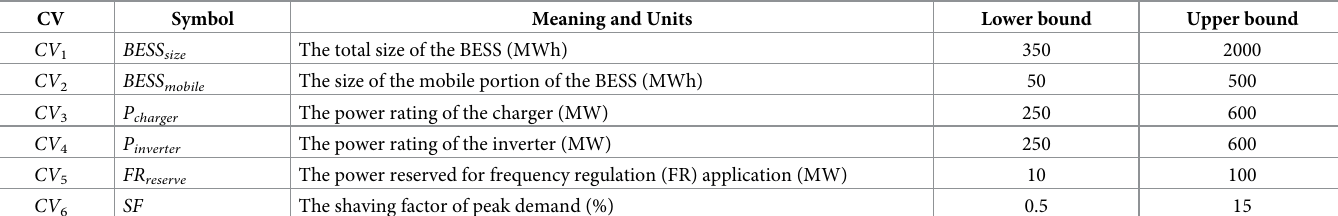
Table 2. Control variables and their bounds.